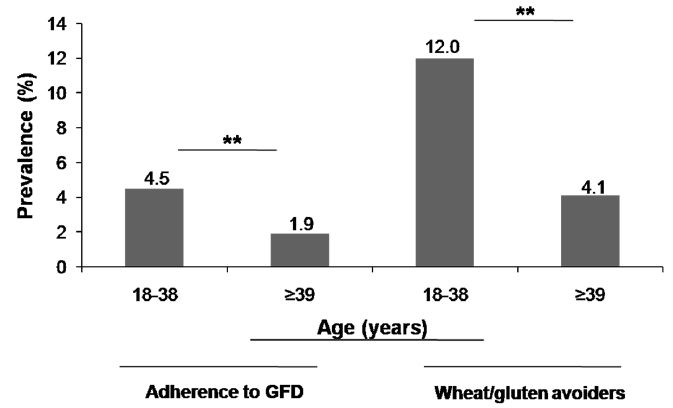
Figure 2. Prevalence of adherence to a GFD and avoidance of wheat/gluten-containing foods stratified by age (years). ** p < 0.01.